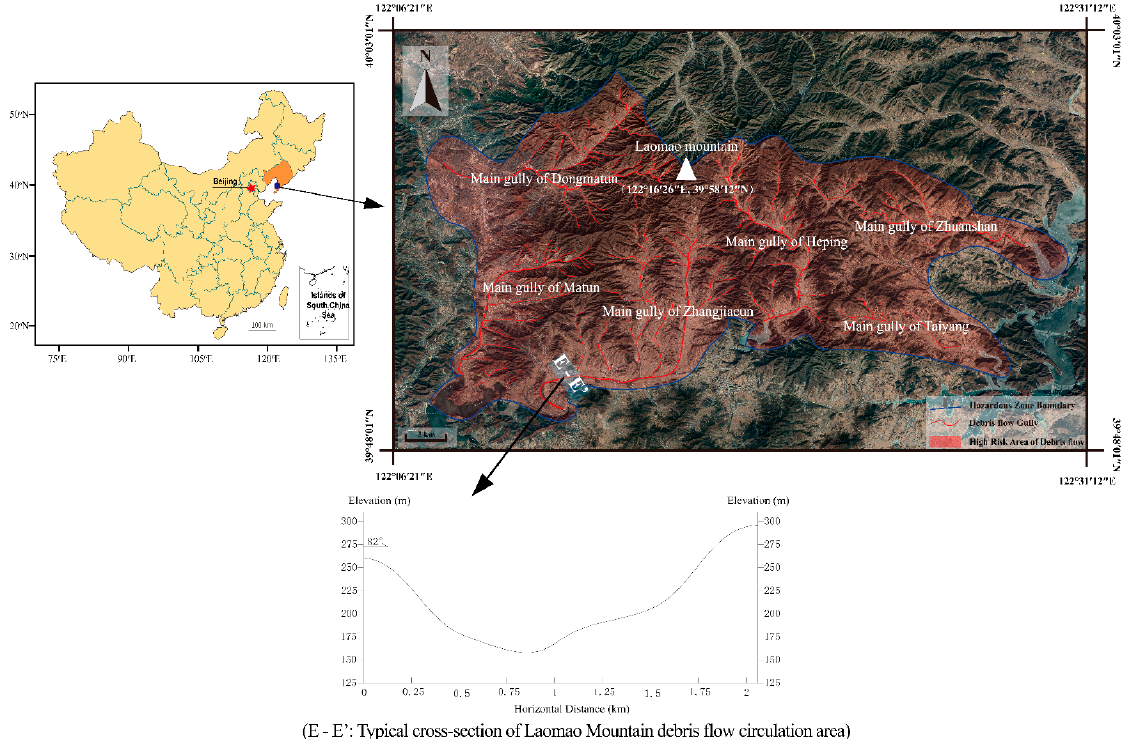
FigureFigure 1. General Situation of Laomao Mountain debris flow. Figure 1. General Situation of Laomao Mountain debris